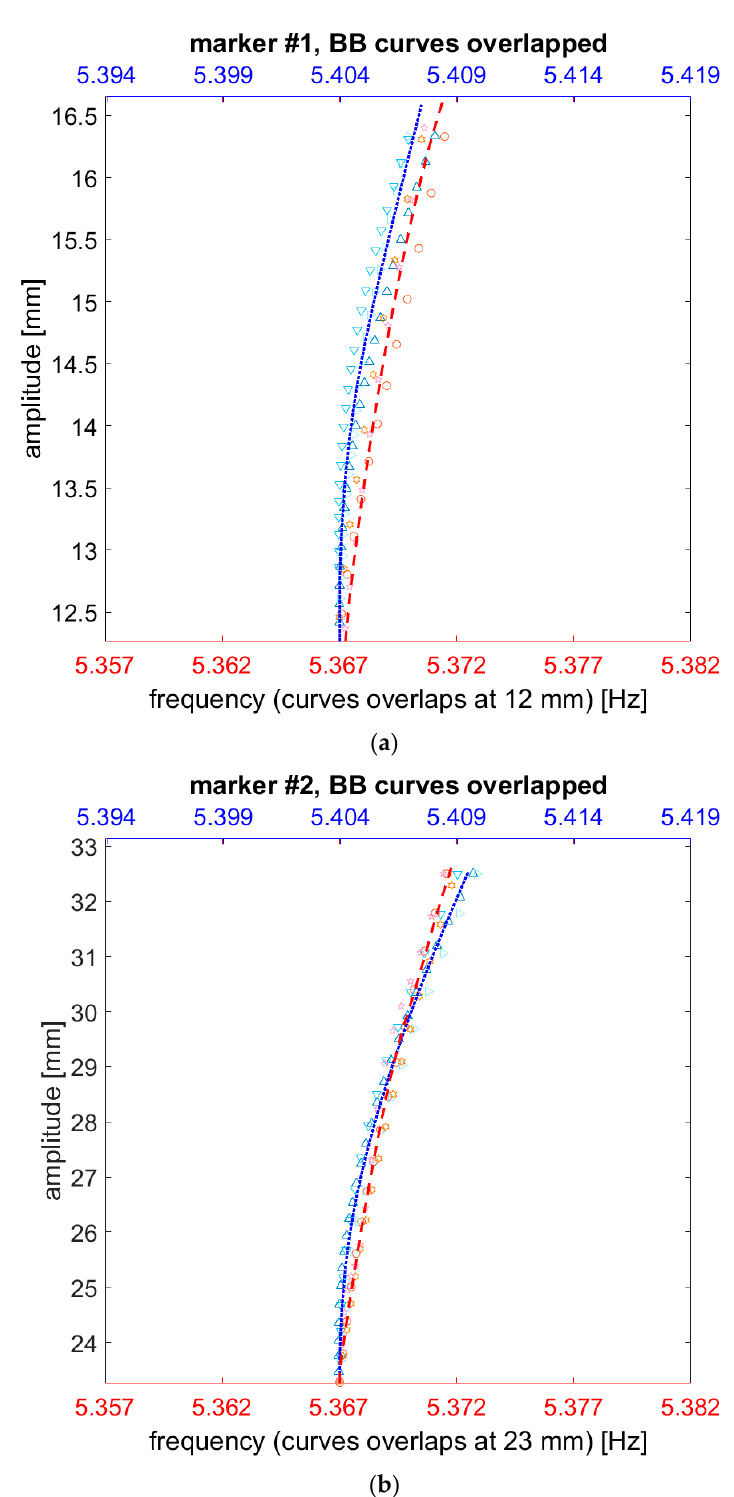
Figure 15. Comparison of backbone curves’ models (loaded vs. unloaded condition) for marker #1 ( a ) and marker #2 ( b ), overlapped. Triangles in shades of blue correspond to the three measurements without sensors. The other red/pink markers refer to the three measurements with sensors attached. The blue dotted and the red dashed lines indicate the models fitted on the respective data. The blue x -axis ( top ) refers to the unloaded condition; the red one ( bottom ) to the sensor-loaded spar.